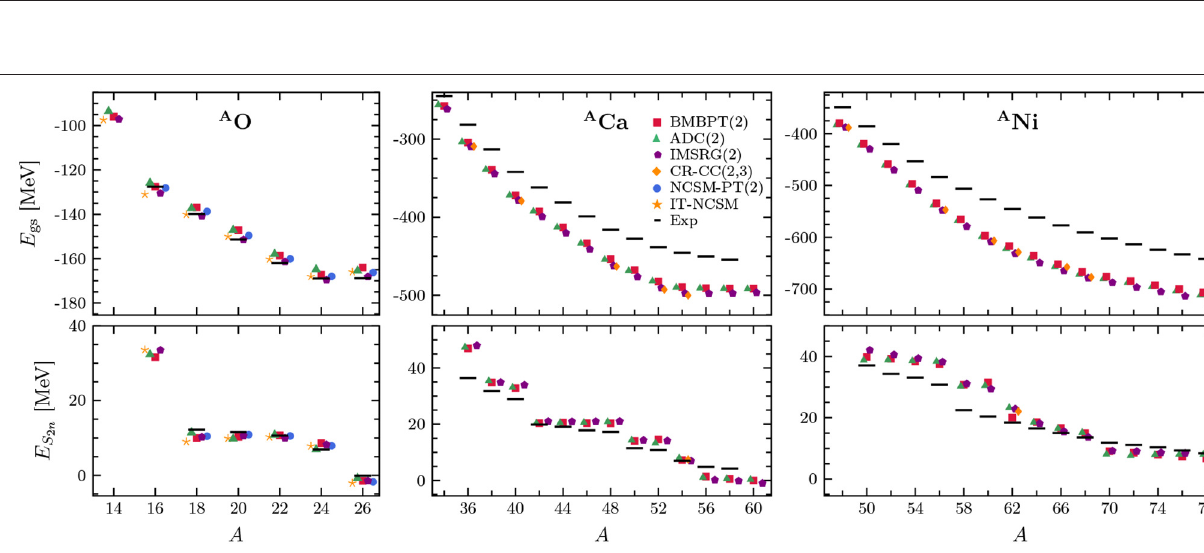
Frontiers in Physics | www.frontiersin.org